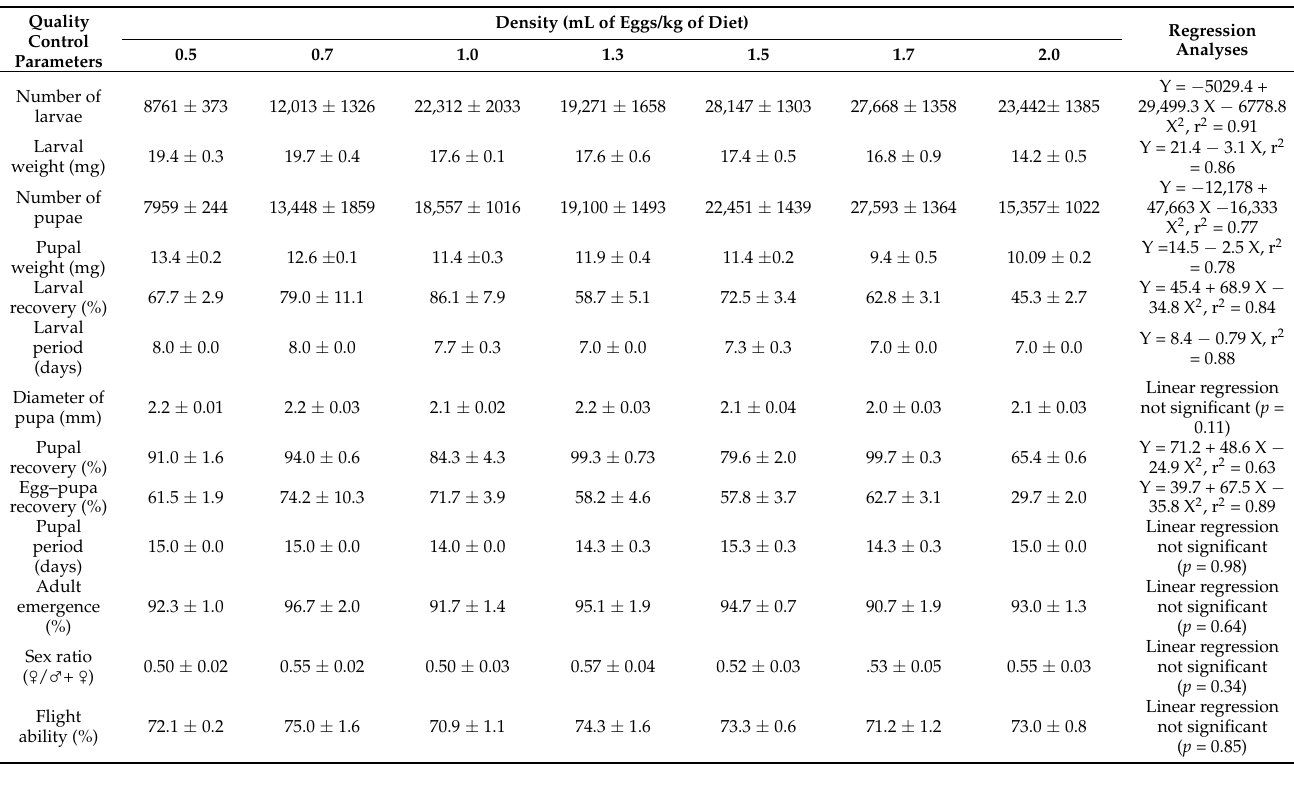
Table 3. Quality control parameters (mean ± SE) for Anastrepha fraterculus reared on a larval diet with corn flour and carrageenan (CENA’s diet) at seven different egg-seeding densities.